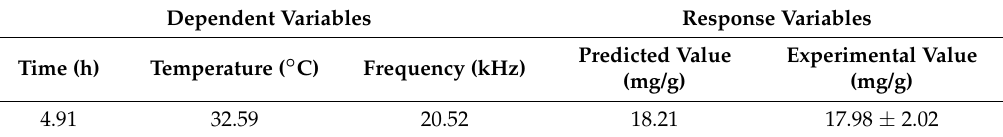
Table 4. Predicted and experimented values of response variables processed under an optimal extraction condition.